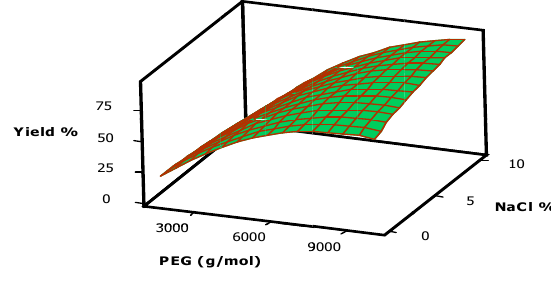
Figure 1. Response surface plots for interaction effects of ATPS purification factors on enzymatic properties of protease. Partition coefficient ( a – b ), purification factor ( c – f ) and yield ( g – j ).